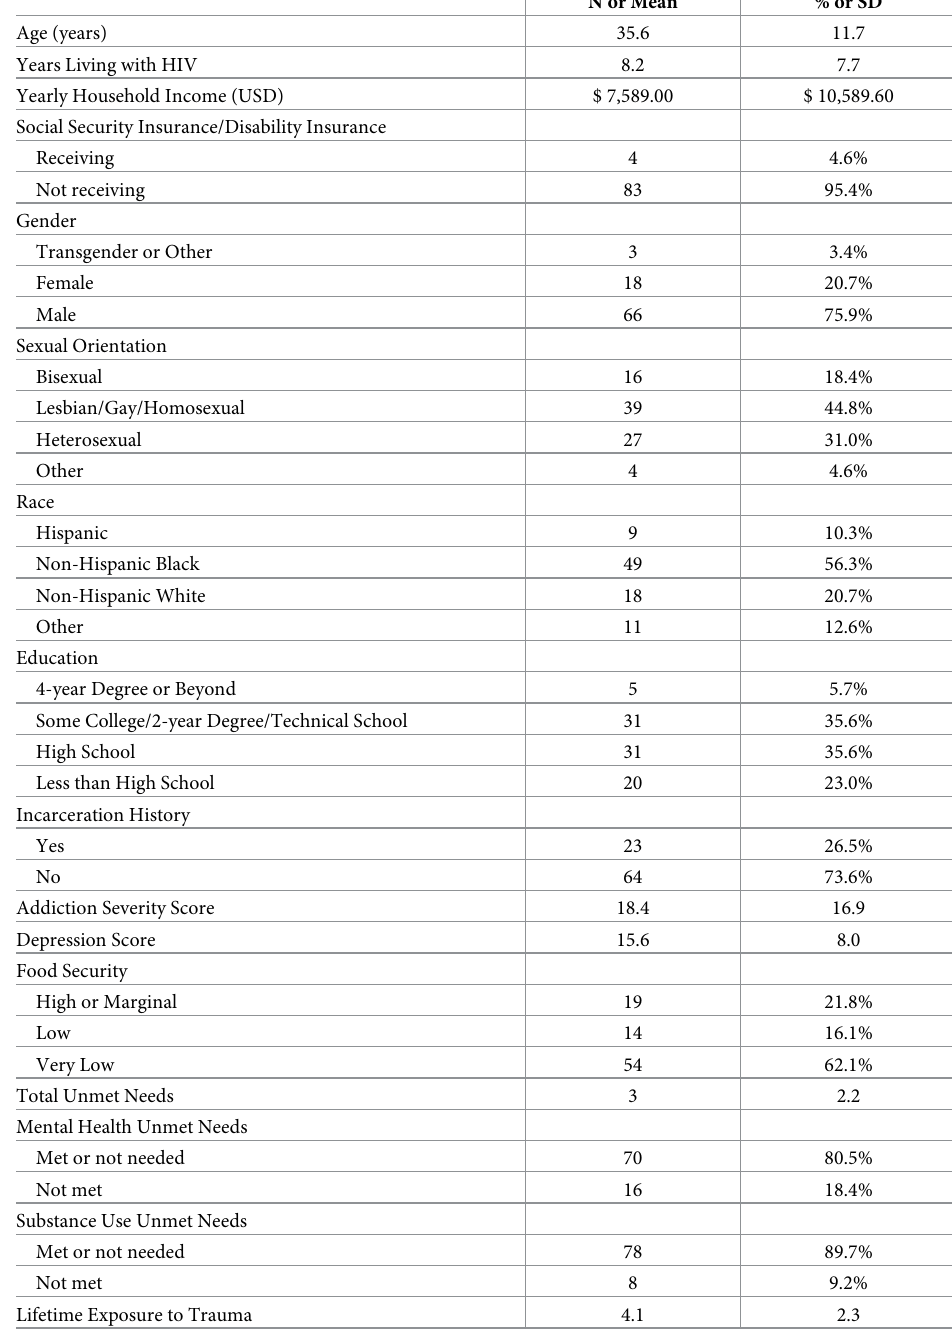
Table 1. Demographic statistics (N =